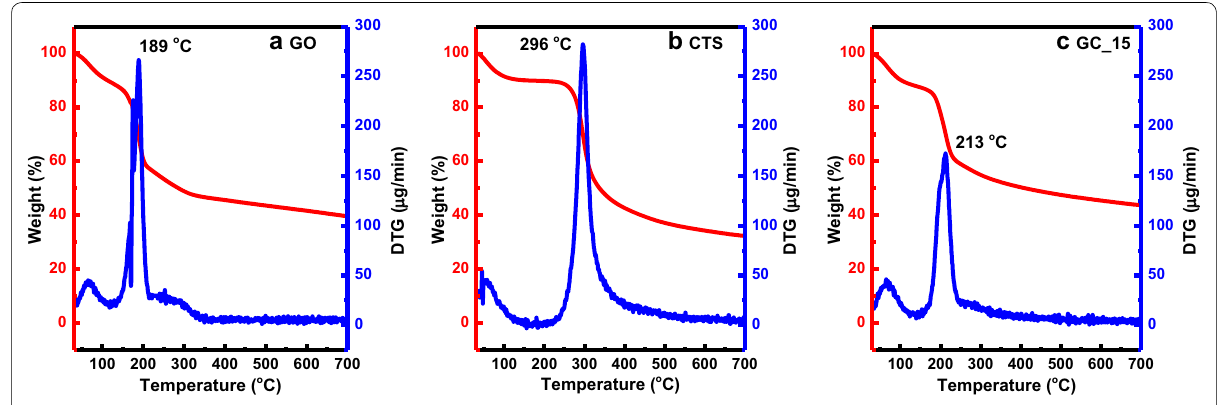
Fig. 6 TGA and DTG results obtained for a GO, b CTS, and c